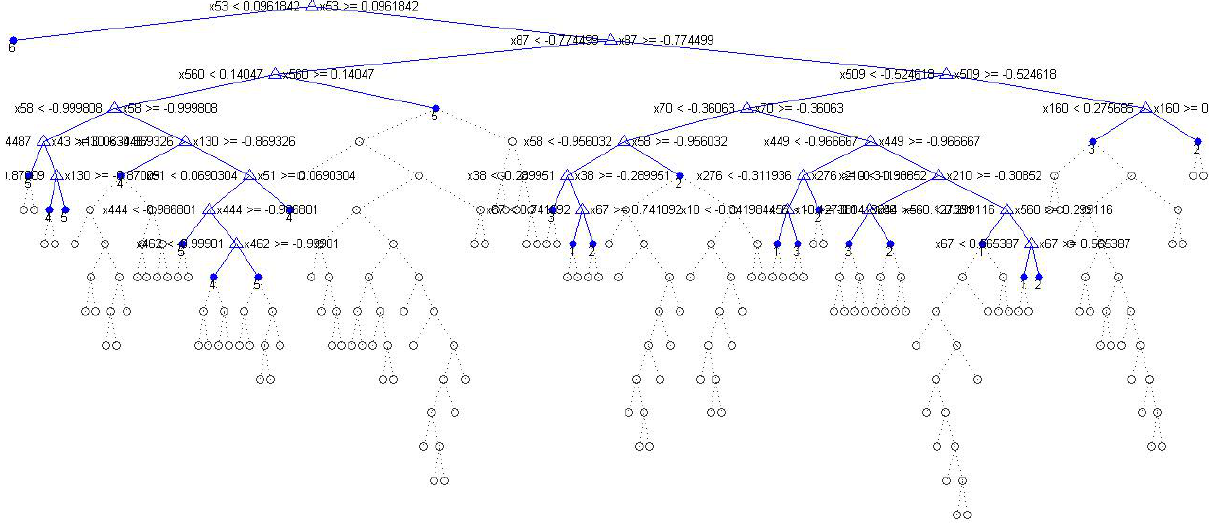
Figure 12. C4.5 bounded decision